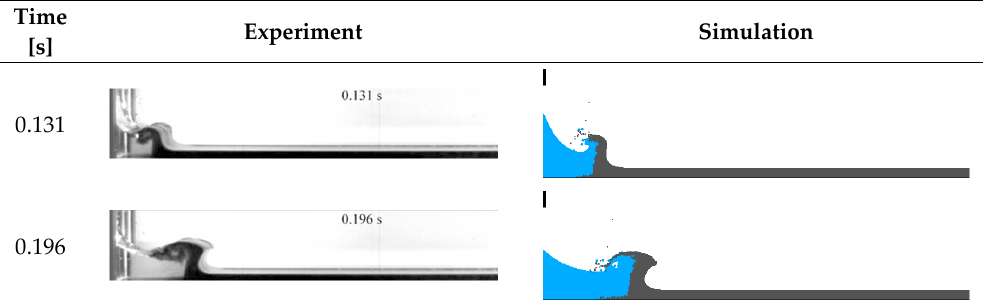
Figure 6. Schematic of the broken dam with soil bed.